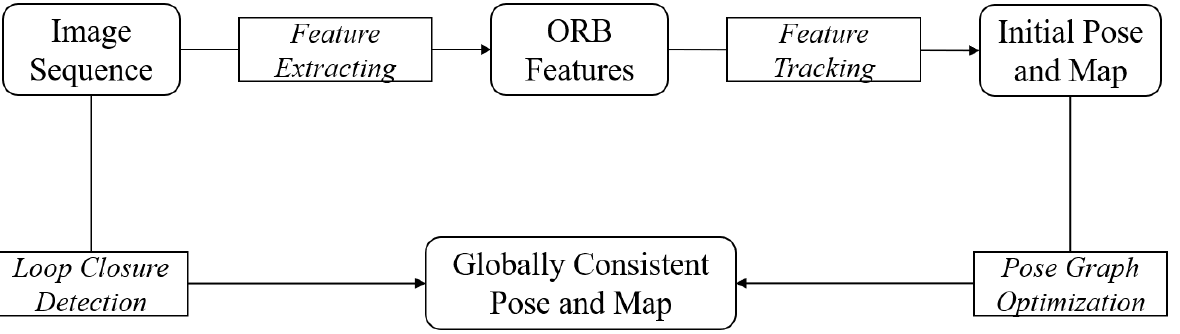
Figure 5. Framework of classical visual SLAM